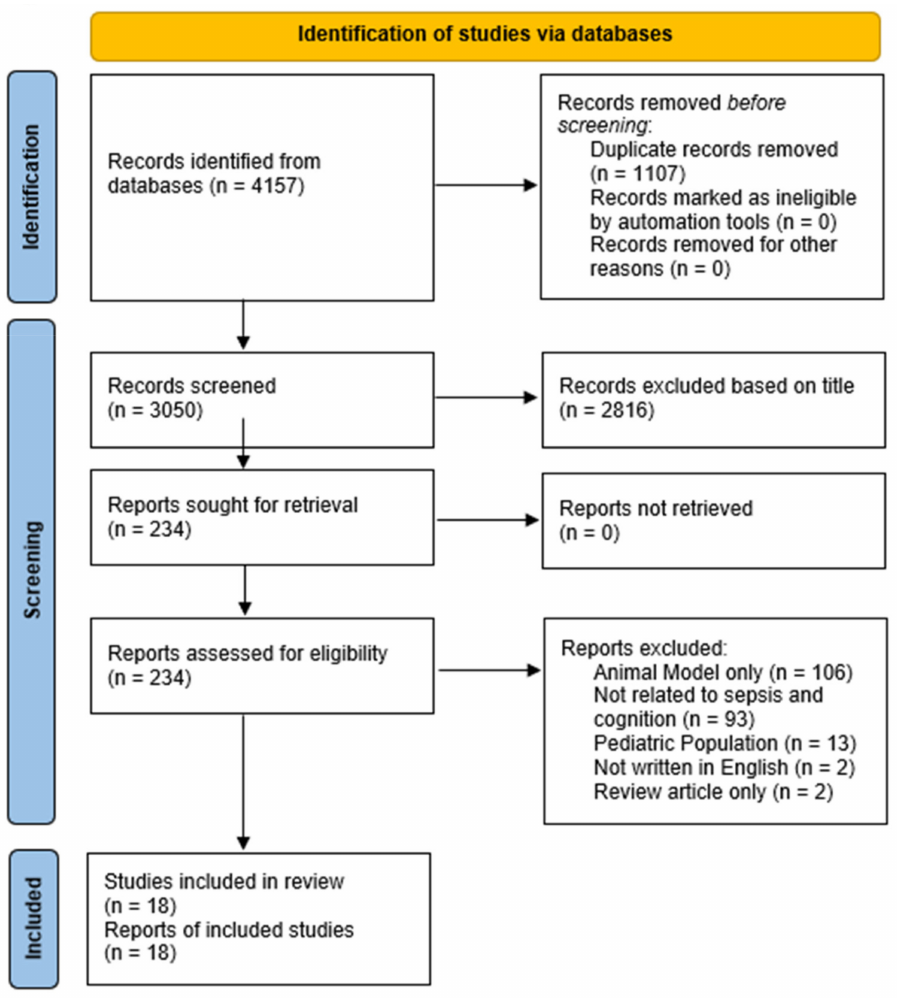
Figure 1. Publication Identification